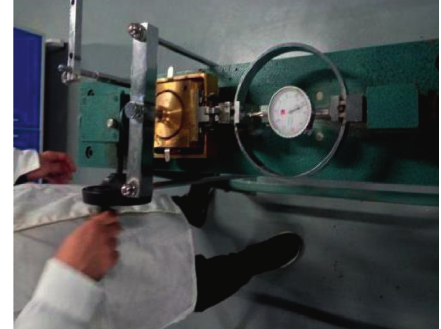
Figure 5: Action cycle of direct shear apparatus.